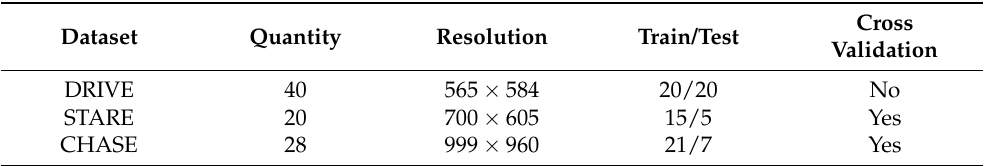
Table 1. An overview of the three public fundus datasets used: total number of images, image resolution (width × height), training and testing split, and whether to perform cross-validation.